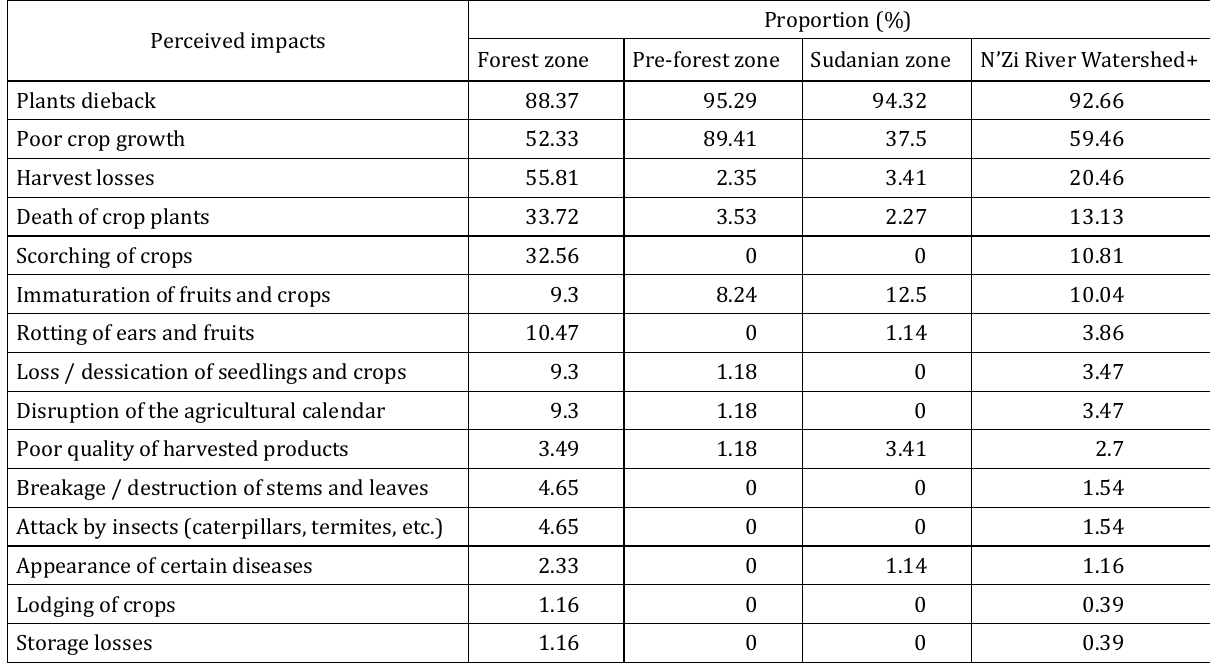
Table 5. Perceived impacts of climate change on